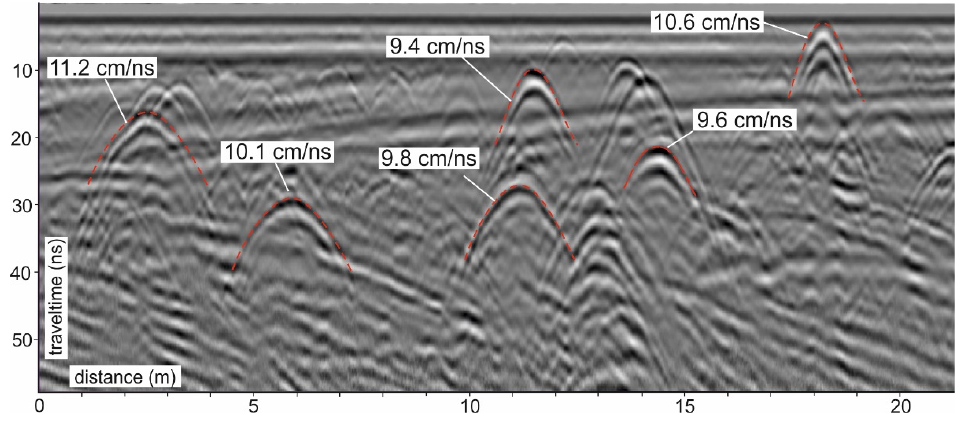
Figure 3. Radar profile with some of the diffraction hyperbolas used for the determination of GPR waves’ velocities. From the velocity dataset, an average velocity of 10 cm/ns was adopted. The GPR profiles are presented in color mode (grey tones), with a relative normalization of amplitudes and no linear/exponential graphical gains.